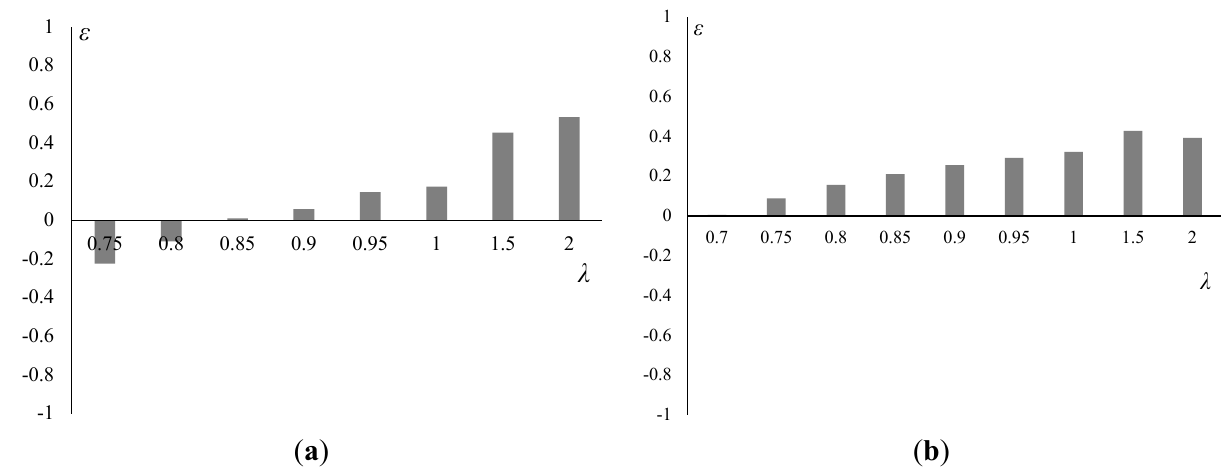
Figure 4. Wave energy pertaining to single storm realizations ( E AS ) versus theoretical values ( E EPS ) calculated by the EPS model with λ = 1: ( a ) the buoy 42001; and ( b ) the buoy 46006.